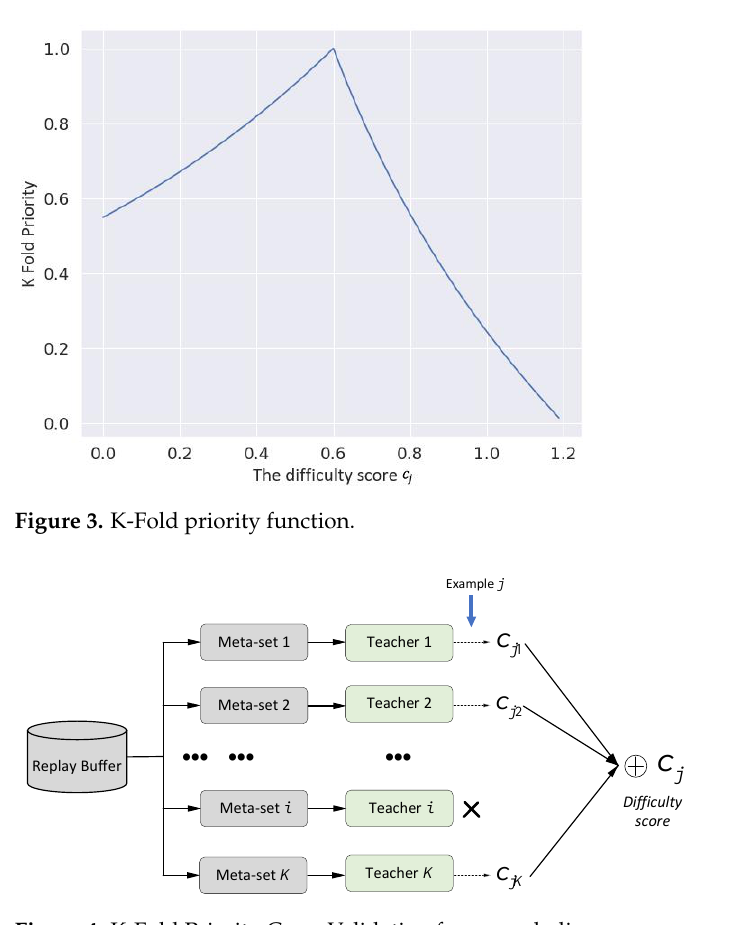
Figure 4. K-Fold Priority Cross Validation framework diagram.